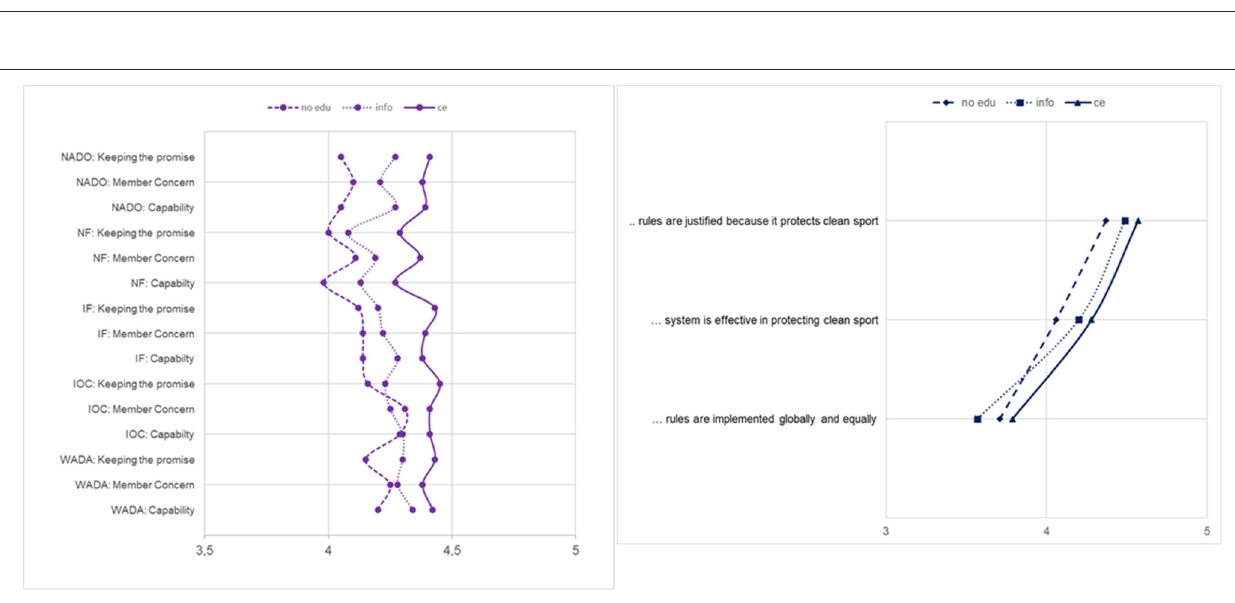
Frontiers in Sports and Active Living |